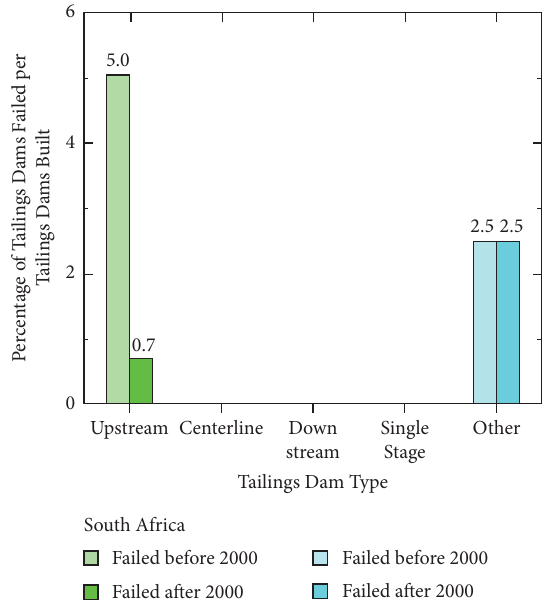
Figure 9: Percentage of tailings dams failed per tailings dams built in South Africa, before and after 2000, according to dam type (data from GRID-Arendal [25], Bowker [22], and Torrez-Cruz [32]).